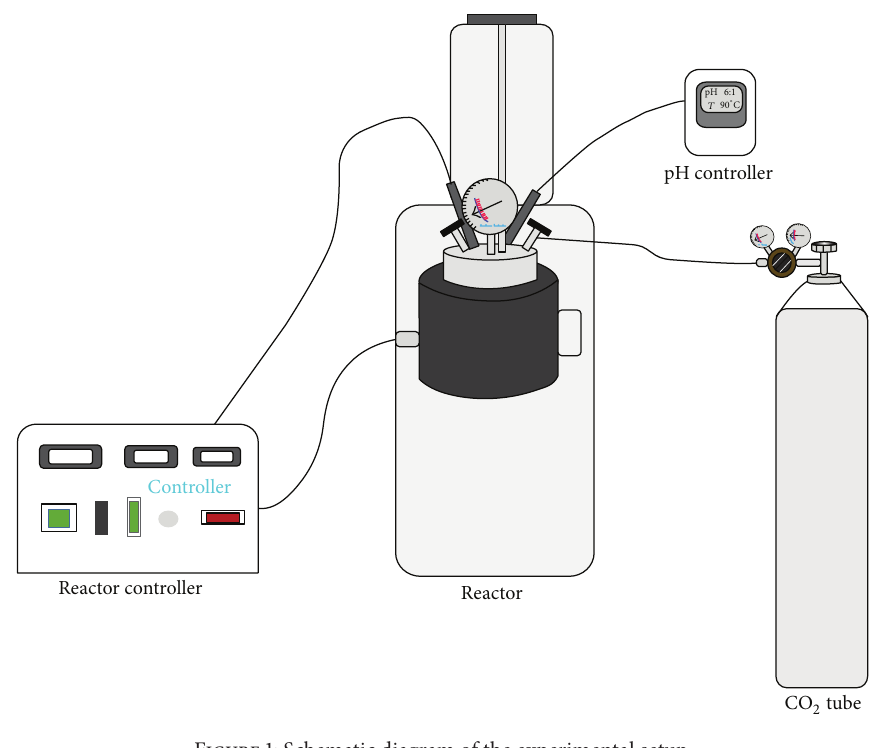
Figure 1: Schematic diagram of the experimental setup.